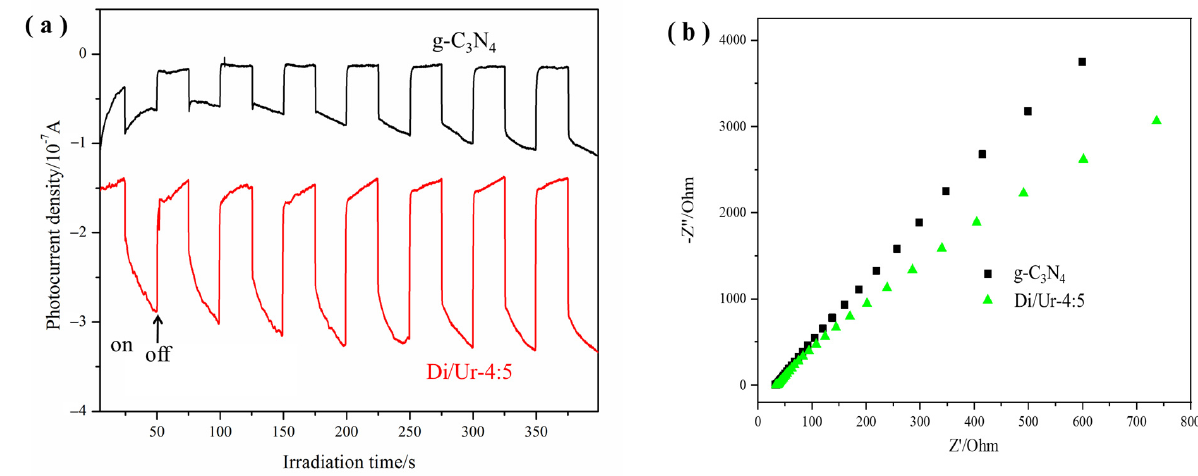
Figure 9. Transient photocurrent responses ( a ), and EIS Nyquist plots ( b ), of pure g-C 3 N 4 and Di/Ur-4:5 composite.